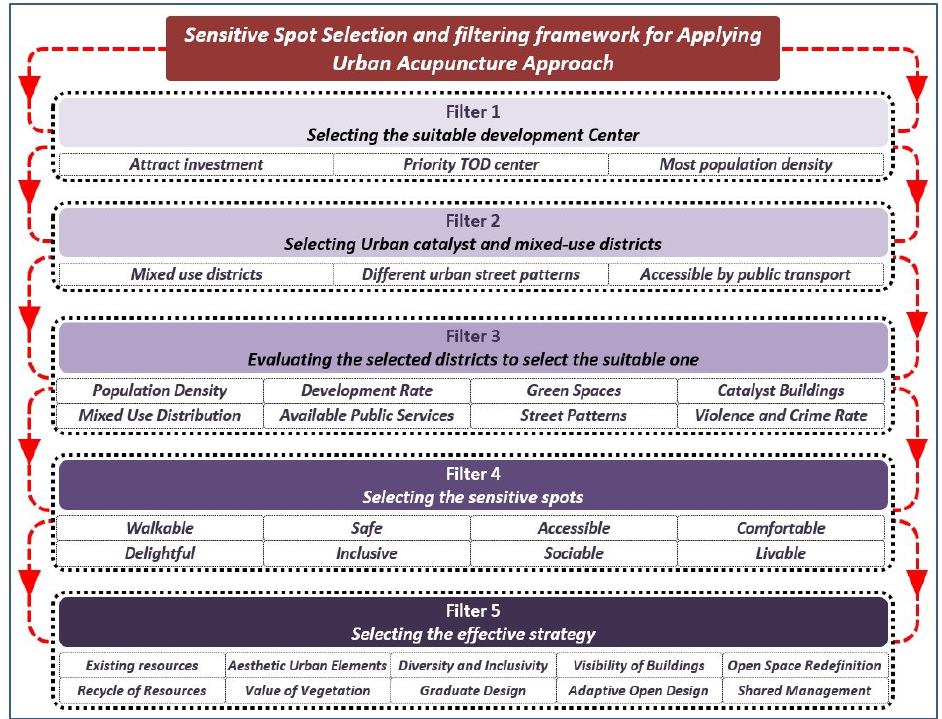
Figure 10. Sensitive spot selection and filtering framework for applying the UA